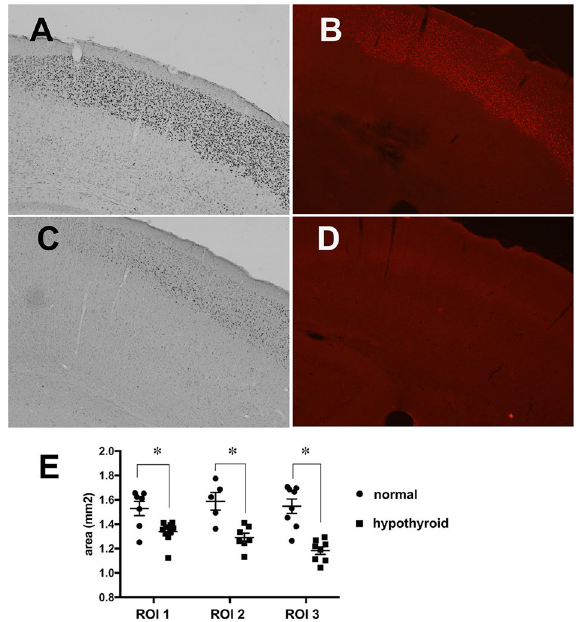
Figure 6. Expression of CUX1 in layers II–IV of the cerebral cortex in mice. ( A – D ) Photomicrographs show immunostaining of CUX1 in the cerebral cortex of normal ( A , B ) and hypothyroid mice ( C , D ), respectively. ( A ) and ( C ) at PD 14; ( B ) and ( D ) at 3-months of age. Scale bar = 500 µm. ( E ) Graph shows the areas of cortical layers II–IV in normal (circle) and hypothyroid mice (square) at 3-months of age. ROI 1: − 0.70 mm to − 1.34 mm, ROI 2: − 1.34 mm to 1.82 mm, ROI 3: − 1.82 mm to − 2.30 mm from the